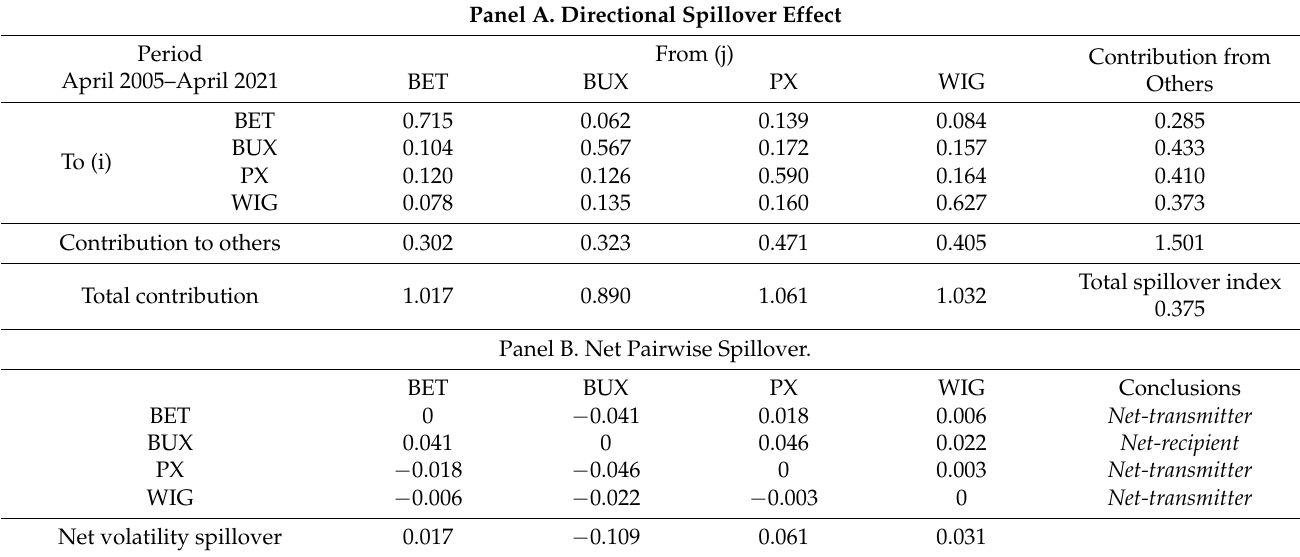
Table 6. The volatility spillover effect in the CEEC stock markets—static. Panel A. Directional Spillover